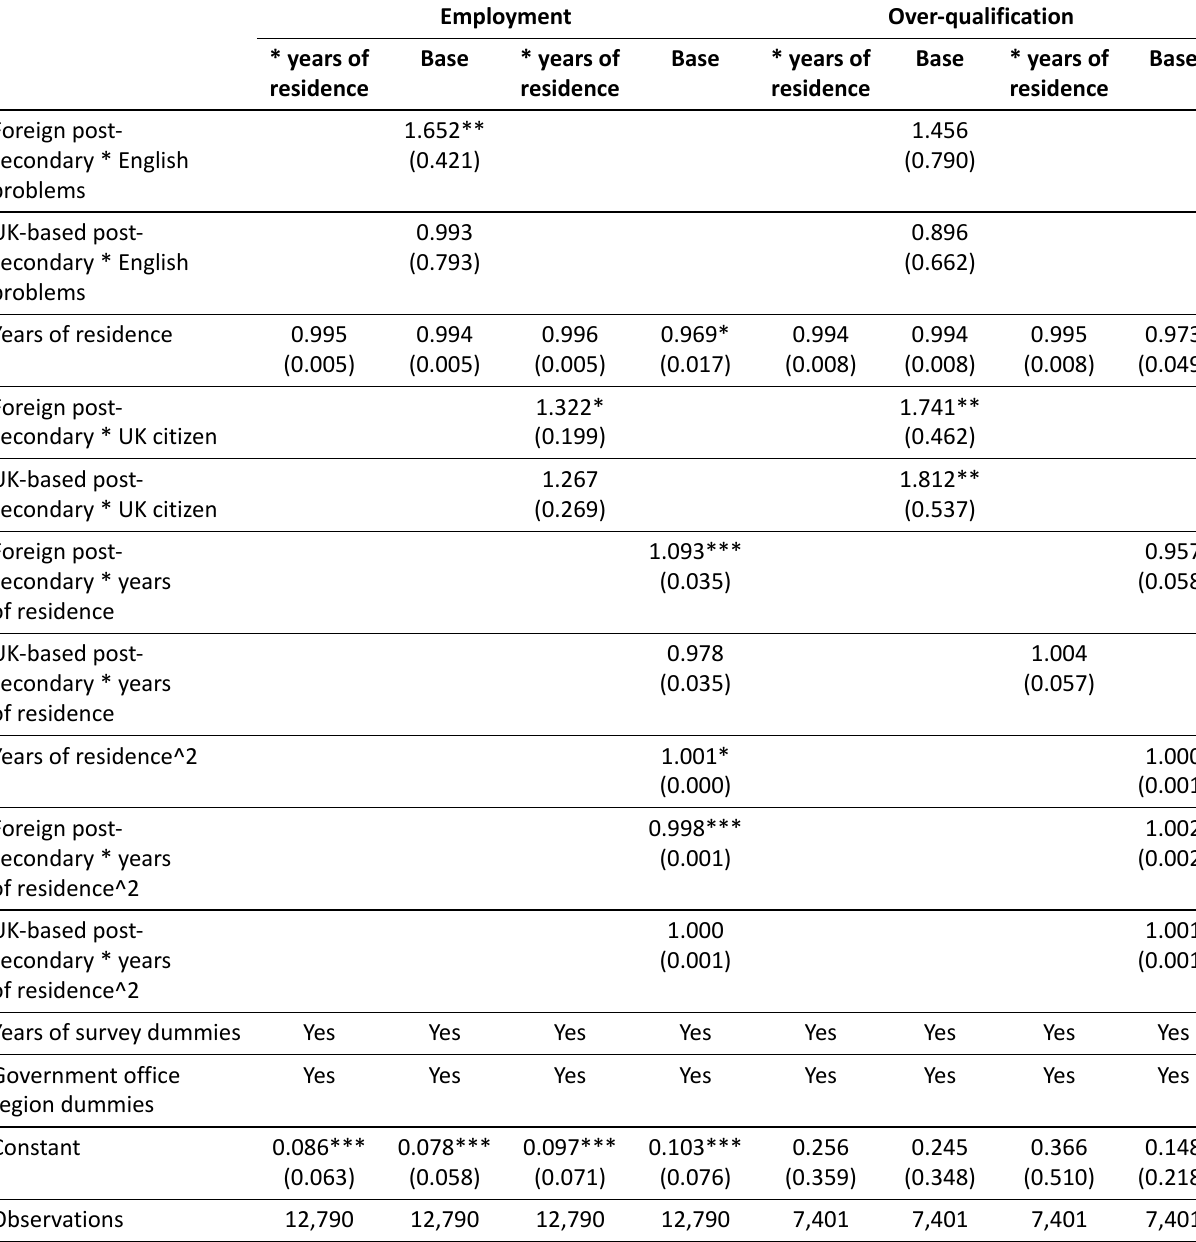
Table A6. (Cont.) Binary logistic regression model with sequential interactions of post-secondary qualifications for women.